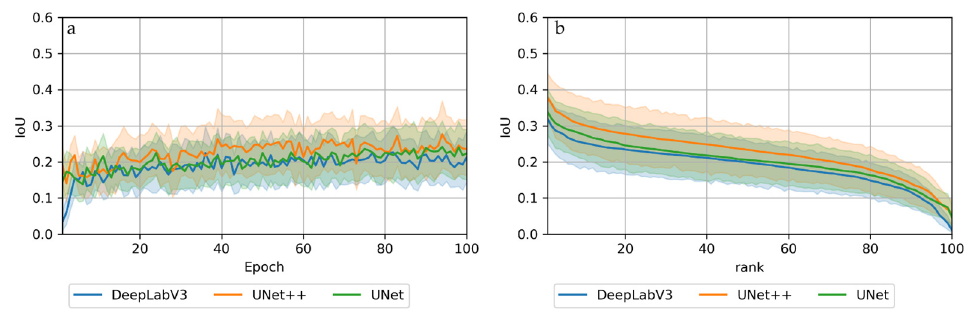
Figure 5. Mean and standard deviation of IoU scores per architecture sorted by ( a ) epoch and ( b ) scores (best to worst). n = 18 (6 sites × 3 encoders) per architecture. Table 5. Regional performance of best sparse models. U++: UNet++; DLv3: DeepLabv3; Rn34: Resnet34; Rn50: Resnet50; Rn101: Resnet101. IoU1/Prec1/Recall1/F 1 1: Metrics of best sparse regional CV model. IoU5: 5th best model of 100. IoU10: 10th best model of 100. Study Site